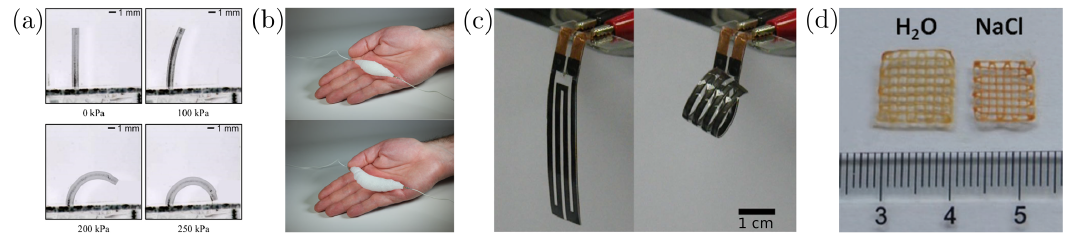
Figure 6. Examples of isotropic transducers. ( a ) Fluidic chambers [18]. Copyright 2018, Springer Nature. ( b ) Phase change material—elastomer composites (PCMEC) [34]. Copyright 2017, Springer Nature. ( c ) Thermal expansion [37]. Copyright 2018, IOP Publishing Ltd. ( d ) Swelling [50]. Copyright 2018, John Wiley and